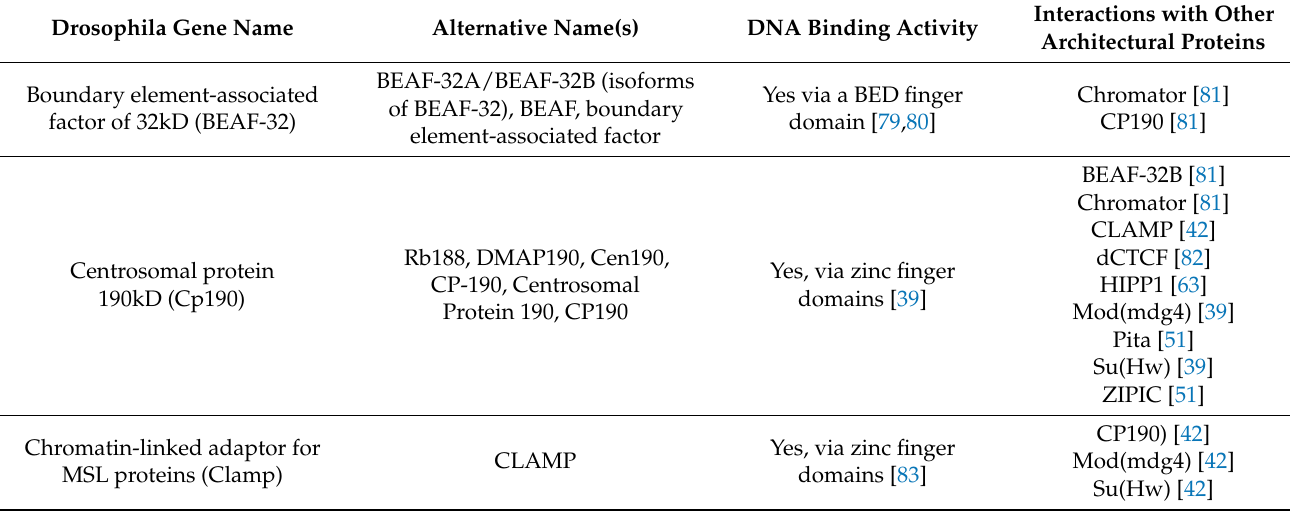
Table 1. Proteins involved in Drosophila TAD architecture. Gene names were acquired from FlyBase [78]. Drosophila Gene